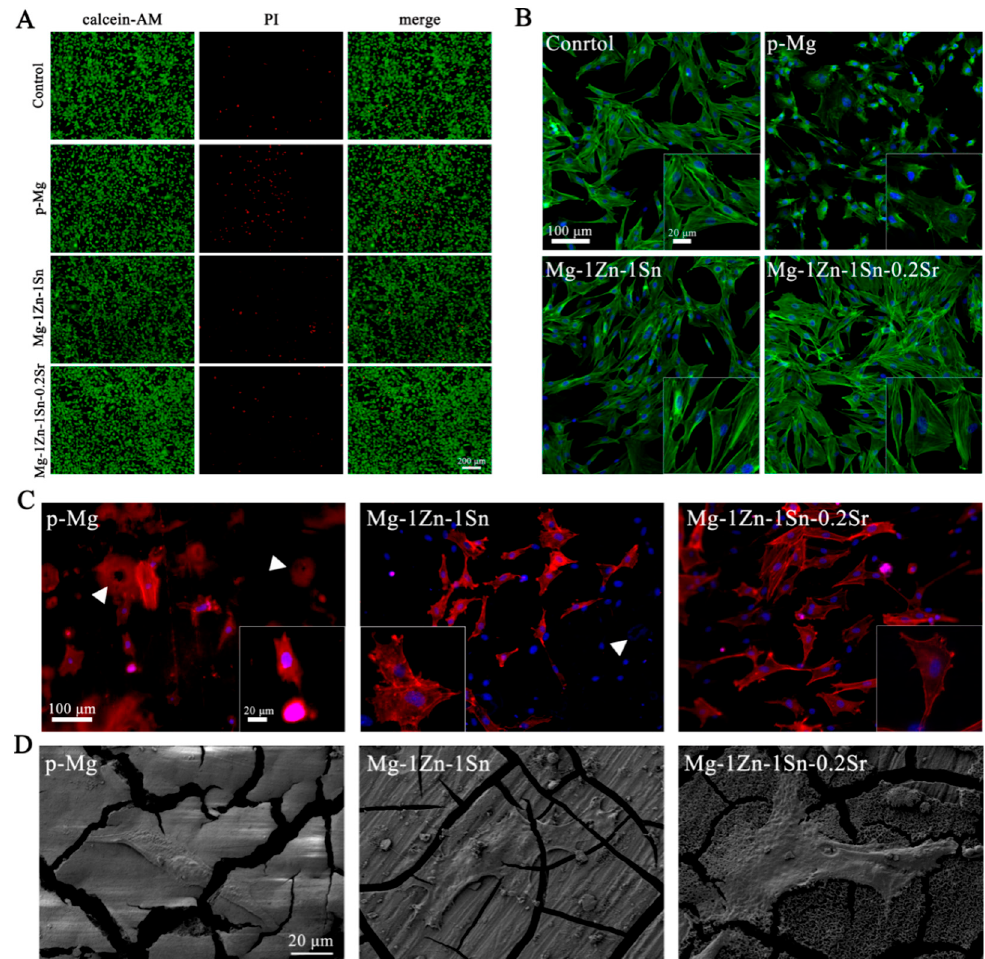
Figure 7. ( A ) Live/dead staining of MC3T3-E1 cells coculture with p-Mg, Mg-1Zn-1Sn and Mg-1Zn-1Sn-0.2Sr alloy extracts and DMEM control for 3 days; scale bar = 200 μ m. ( B ) Actin-nucleus co-staining of MC3T3-E1 morphologies coculture with p-Mg, Mg-1Zn-1Sn and Mg-1Zn-1Sn-0.2Sr alloy extracts and DMEM control for 3 days. Scale bar = 100 μ m. Insets were taken at 200 original magnification with scale bar = 20 μ m. ( C ) Fluorescence images of MC3T3-E1 adhered to the surface of p-Mg, Mg-1Zn-1Sn and Mg-1Zn-1Sn-0.2Sr alloys after coculture for 3 days. Blue indicates nuclei, and red indicates cytoskeleton. White triangle indicates corrosion pit on the sample surface. The scale bar = 100 μ m. Insets were taken at 200x original magnification with scale bar = 20 μ m. ( D ) Morphologies of MC3T3-E1 cells adhered to the surface of p-Mg, Mg-1Zn-1Sn and Mg-1Zn-1Sn-0.2Sr alloys after coculture for 1 day. Scale bar = 20 μ m.